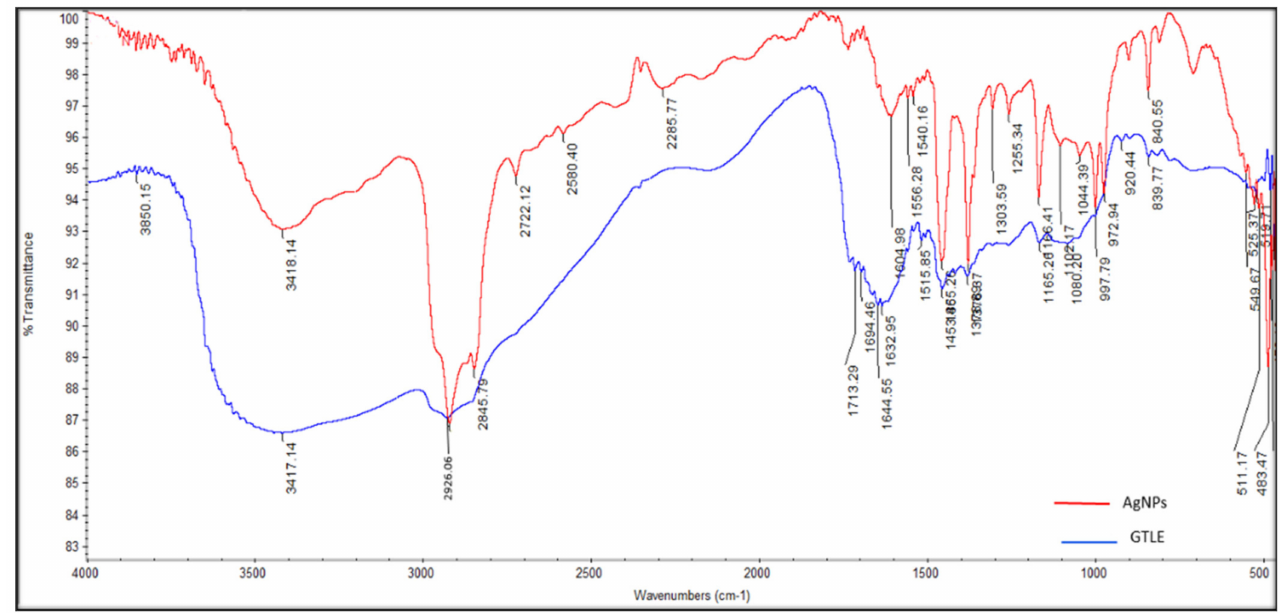
Figure 3. FTIR spectrum of the biosynthesized AgNPs by GTLE compared to